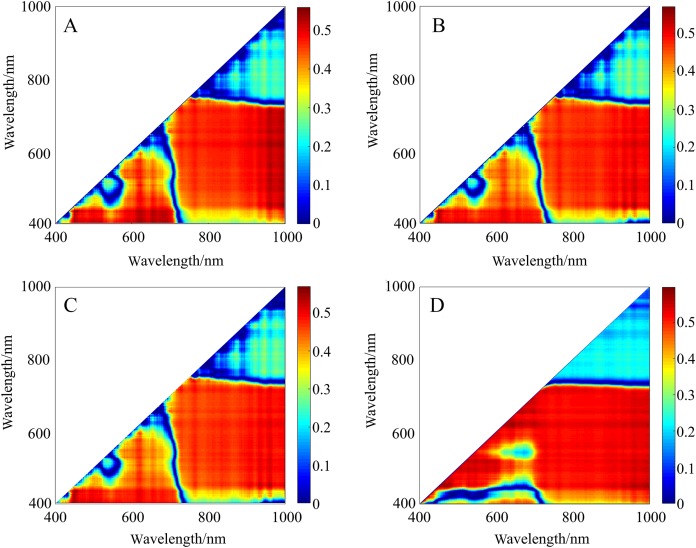
r2 maps of 2D optimal spectral indices based on different pretreatments.(A) r2 maps of A_DI(431,446). (B) r2 maps of CR_NDI(431,446). (C) r2 maps of CR_RI(431,446). (D) r2 maps of A_PI(446,471). The colorbar illustrates the value of the square of the correlation coefficient (r2) between SMC and spectral indices, and the x-axes and y-axes indicate the wavebands of 400–1,000 nm. Dark red portrays a high r2 between SMC and the spectral indices. To improve the comparison, r2 was converted into the absolute value of the correlation coefficient (|r|) to evaluate its validity.